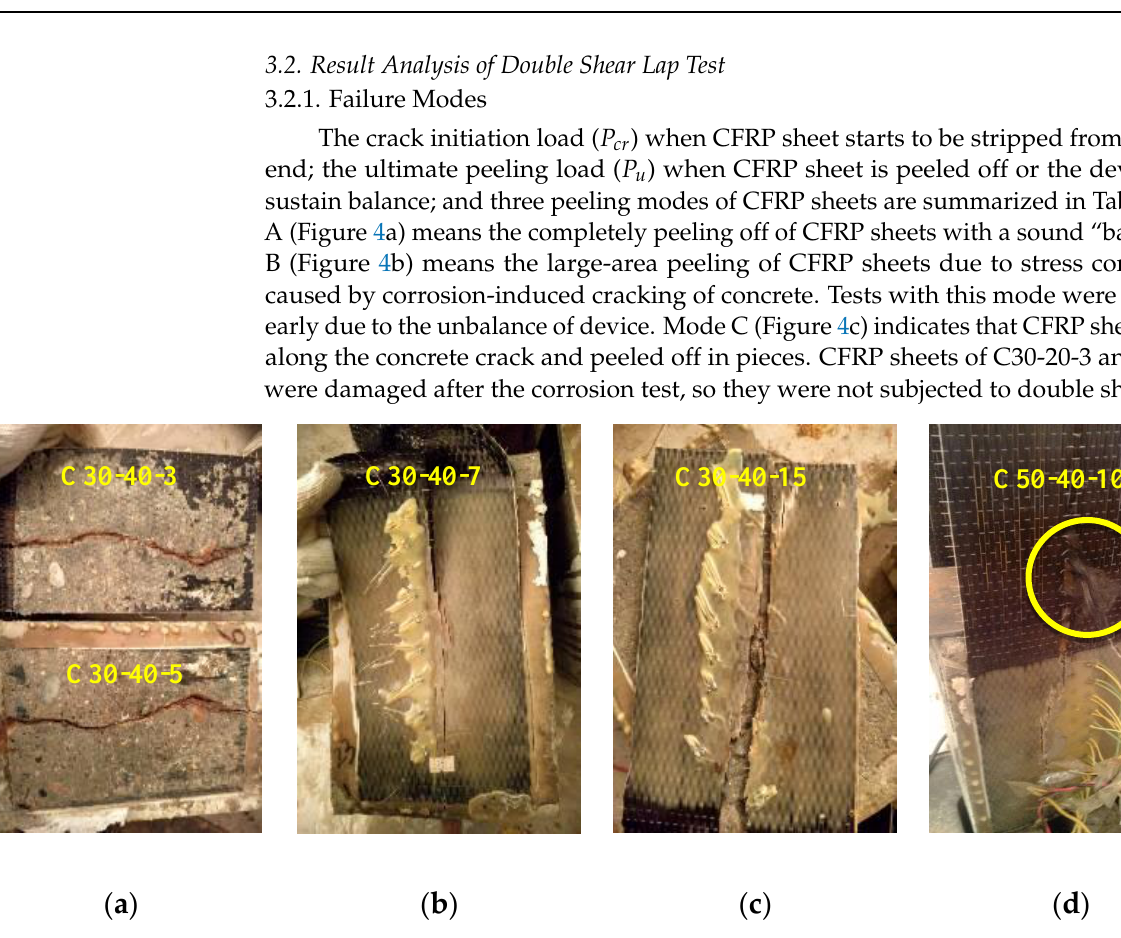
Figure 4. Typical failure modes of specimens: ( a ) Failure mode A; ( b ) Failure mode B; ( c ) Failure mode C; ( d ) Partially teared of CFRP fiber.